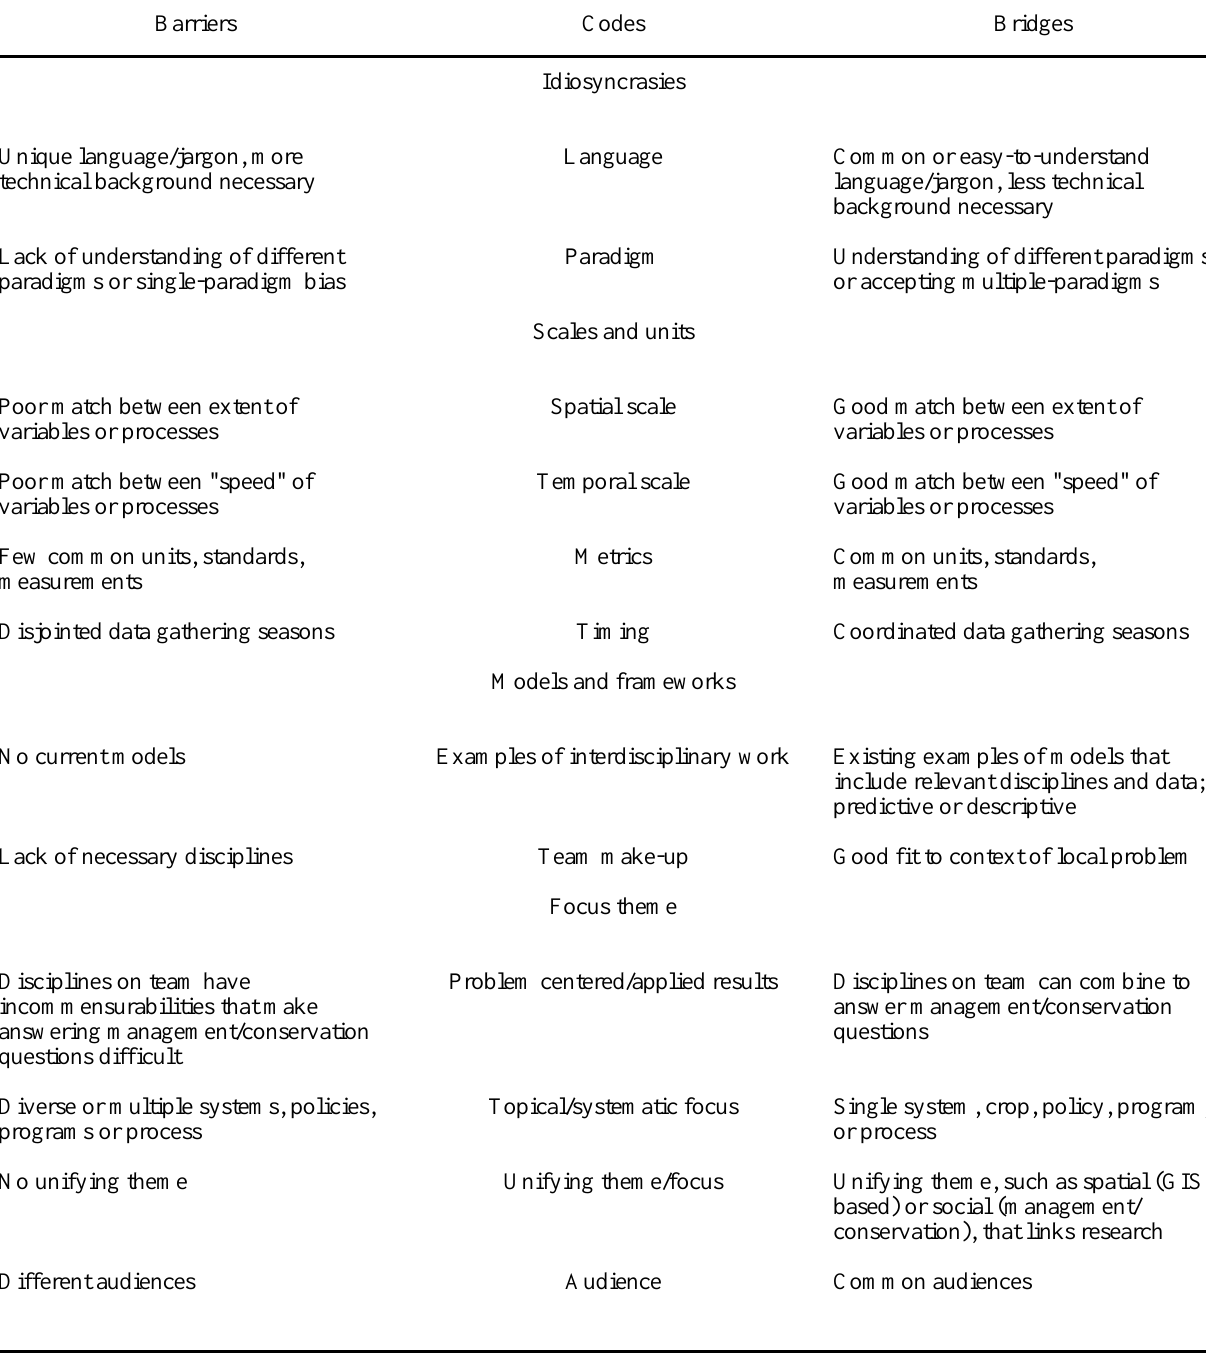
Table 4 . Disciplinary bridges and barriers to integrated interdisciplinary